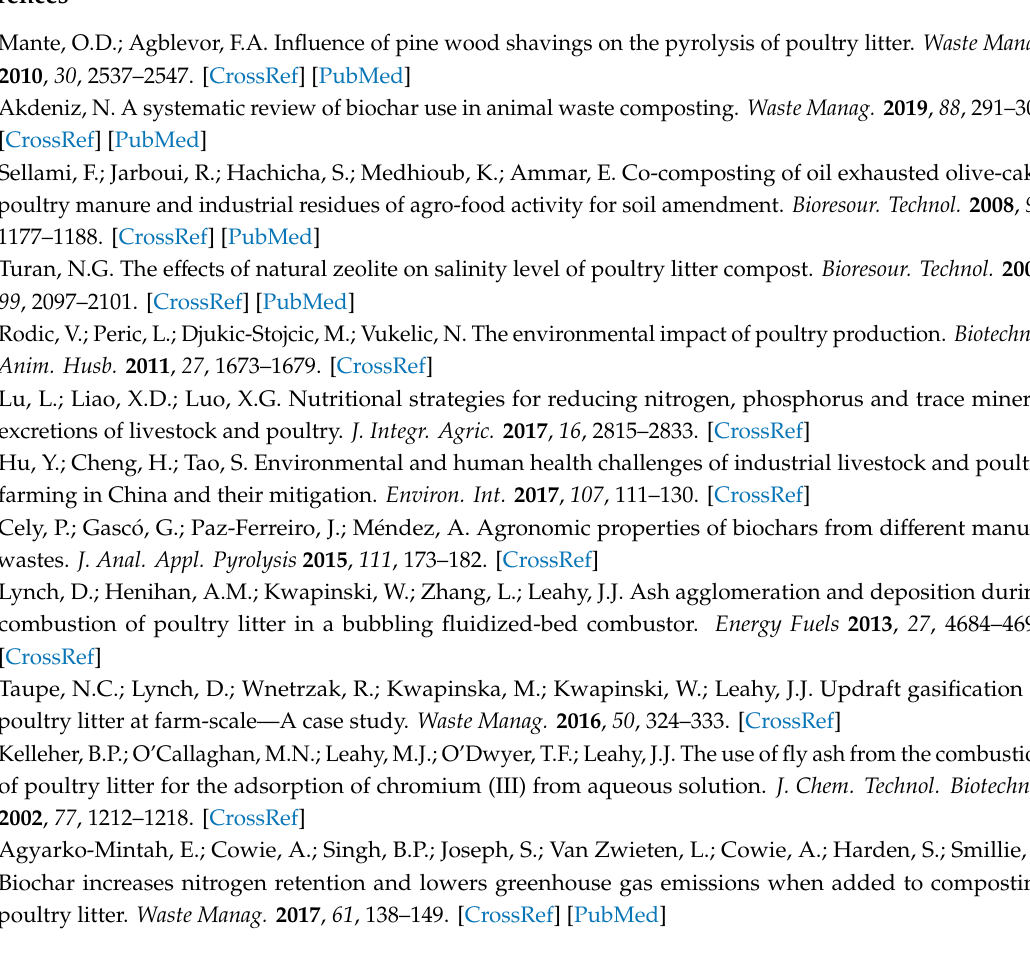
Figure S1: SEM images of surface surfaces morphologies of RPM (a), B400 (b) and B600 (c), Figure S2: XRD images of crystalline phases of RPM, B400 and B600 (OM: organic matter; Q: quartz; C: calcite; S: sylvite and